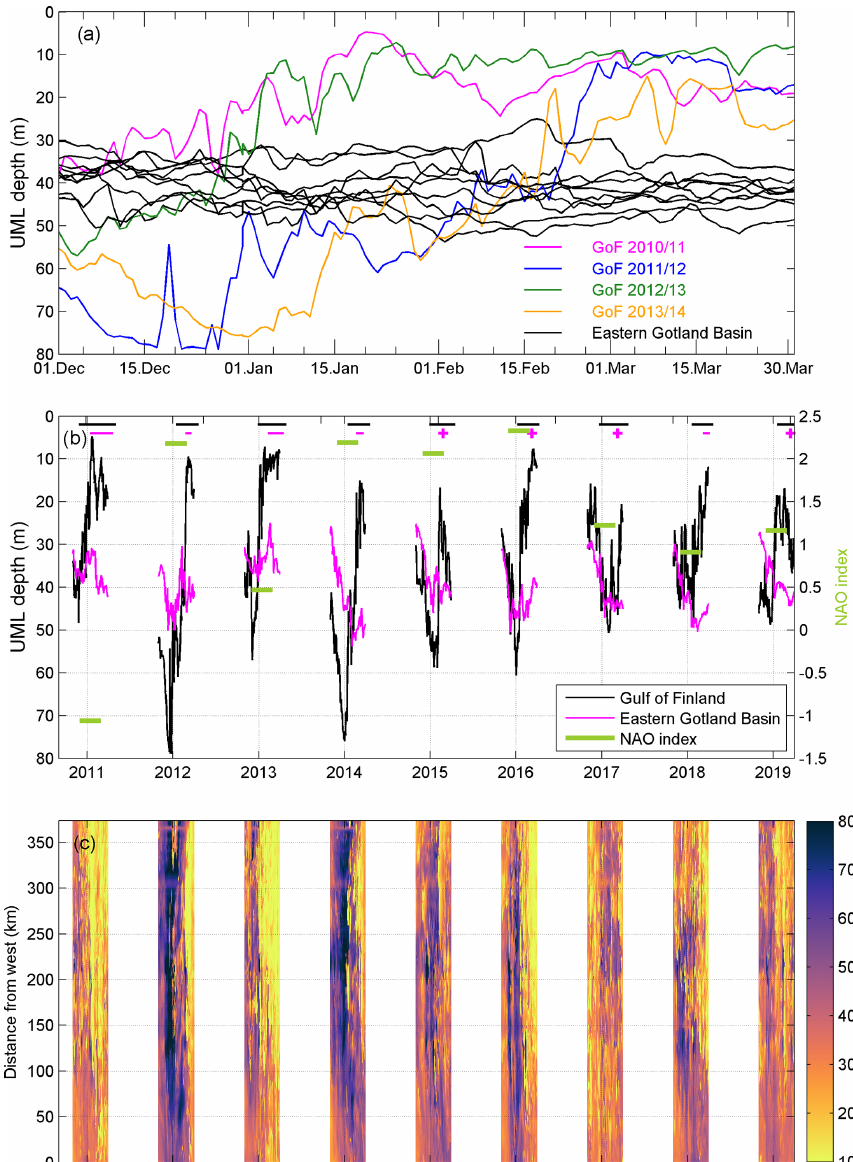
Figure 10. (a, b) Time series of mean upper mixed-layer depth in the Gulf of Finland and Eastern Gotland Basin based on model simulation data from November to March 2010 to 2019. The areal mean in (a) is calculated for the selected transect in the Gulf of Finland (thalweg GoF, Fig. 1) and for the box in the Eastern Gotland Basin (Fig. 1). Only the selected four winters are shown for the Gulf of Finland to illustrate the difference between years with a high positive NAO index (2011/2012, 2013/2014) and low NAO index (2010/2011, 2012/2013), but all winters 2010–2019 are shown for the Eastern Gotland Basin in (a) . In (b) , green horizontal lines mark the mean December–February NAO index (from Jones et al., 1997); black and pink horizontal lines mark where the OSTIA SST is below T md , and pink crosses indicate where the minimum winter temperature did not fall below T md in the Eastern Gotland Basin. (c) The depth of the upper mixed layer along the transect from the northern Baltic Proper to the central Gulf of Finland (thalweg in Fig. 1) for November to March 2010 to